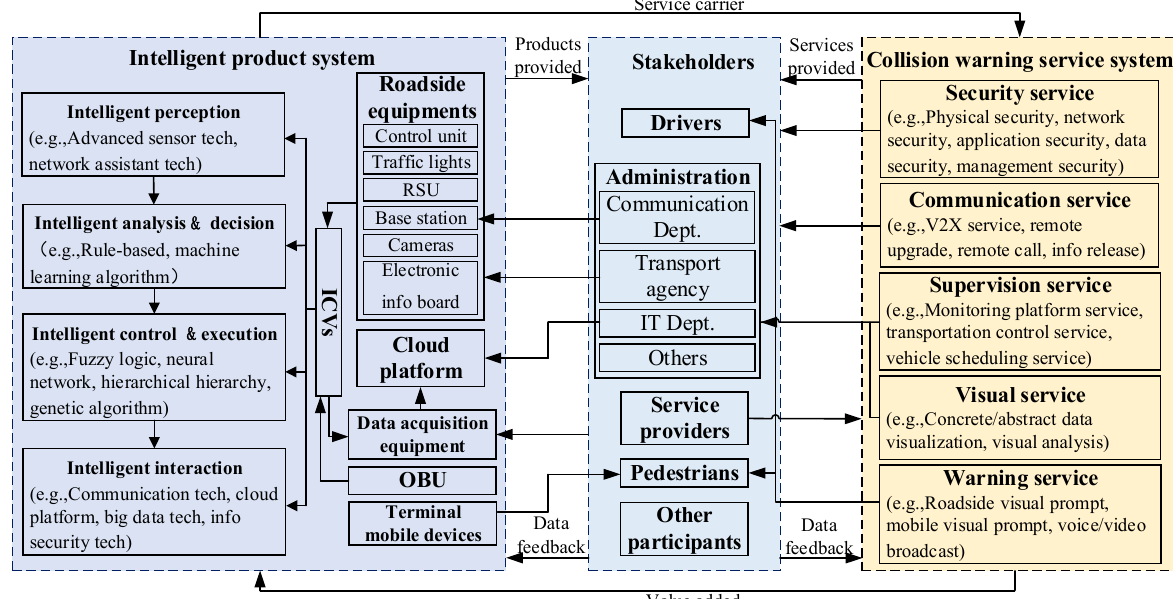
Figure 10. Extended CWS from the perspective of smart PSS.